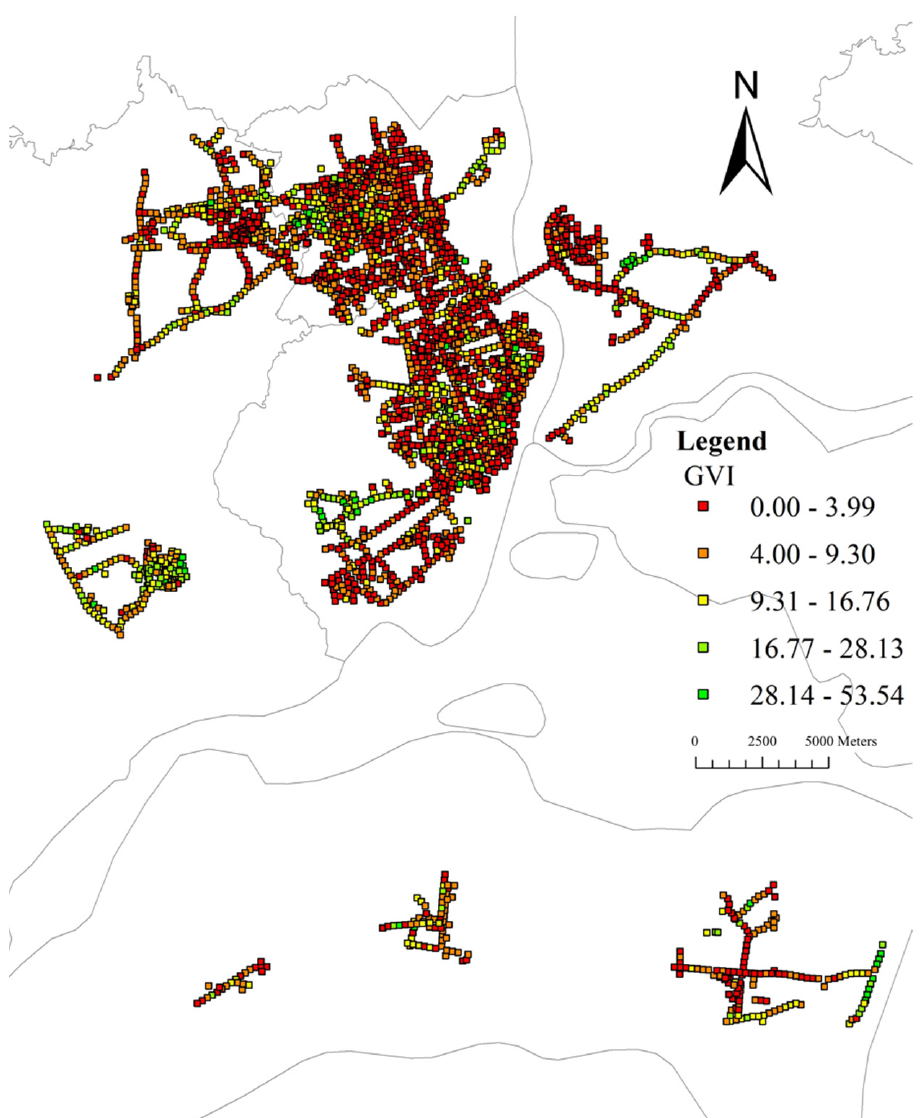
Figure 6. GVI histogram.